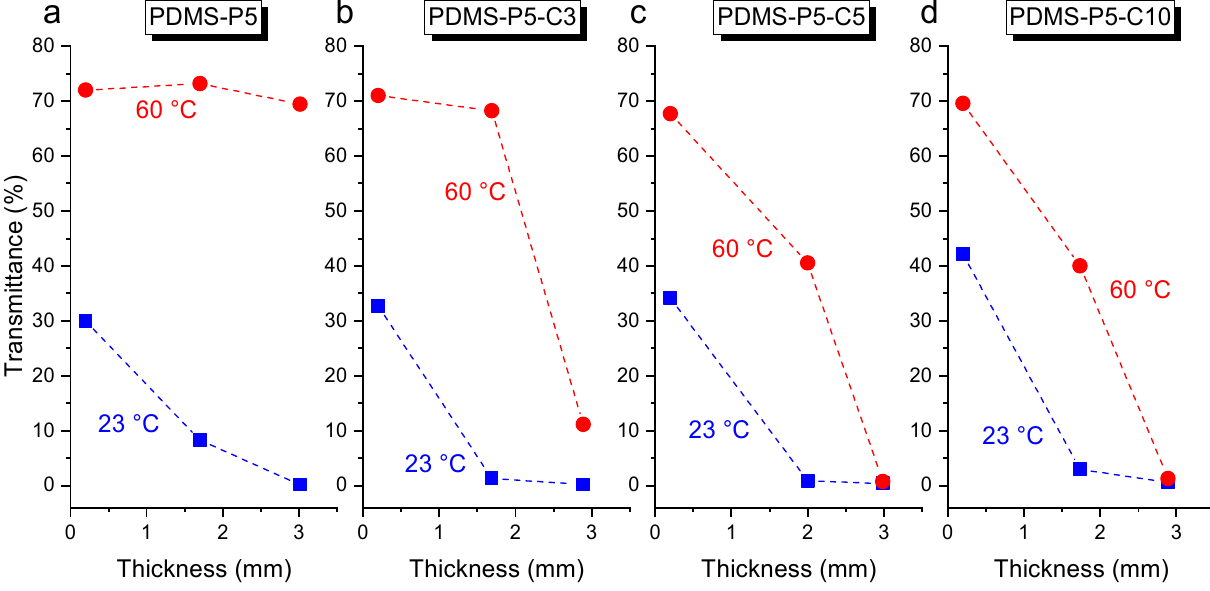
Figure 10. Values of transmittance at 550 nm (at 23 °C and 60 °C) of the samples PDMS-P5-Cx (x = 1–10 phr compared to paraffin), as a function of their thickness.